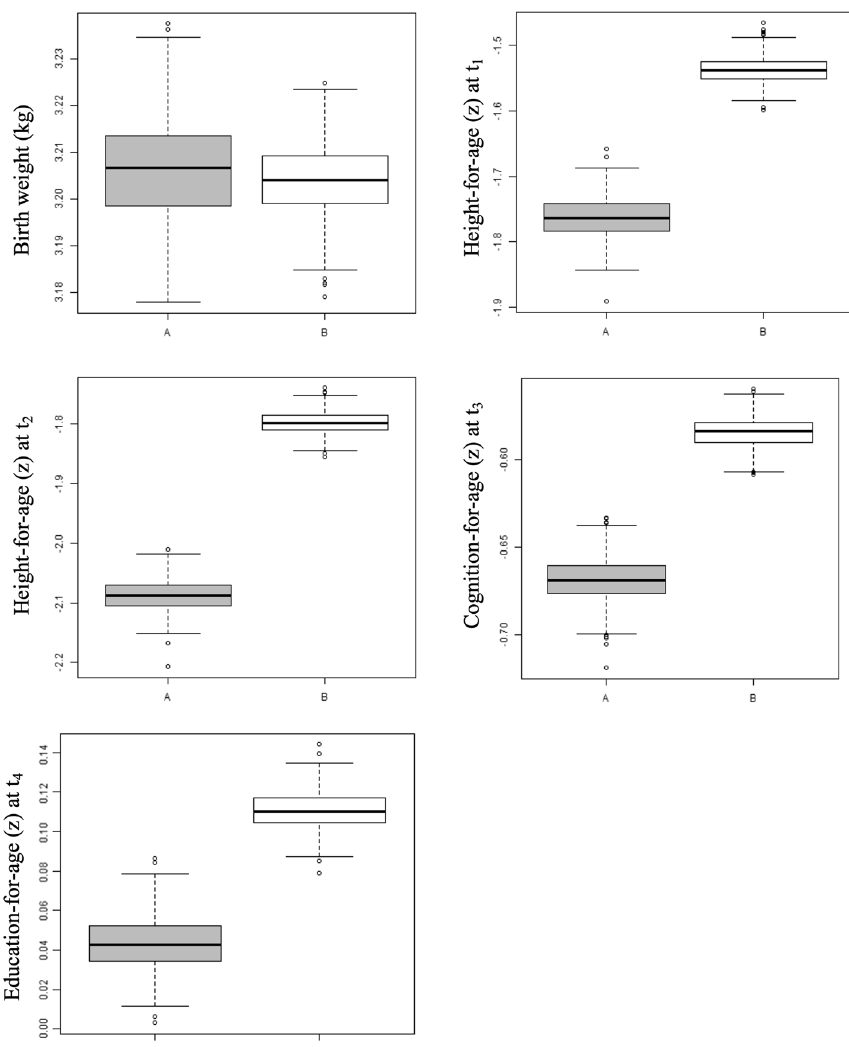
Fig. 3 Simulated counterfactual scenarios from maternal fixed effects models: ( A ) baseline (no manipulation) and ( B ) exogenous change in family planning services (low fertility